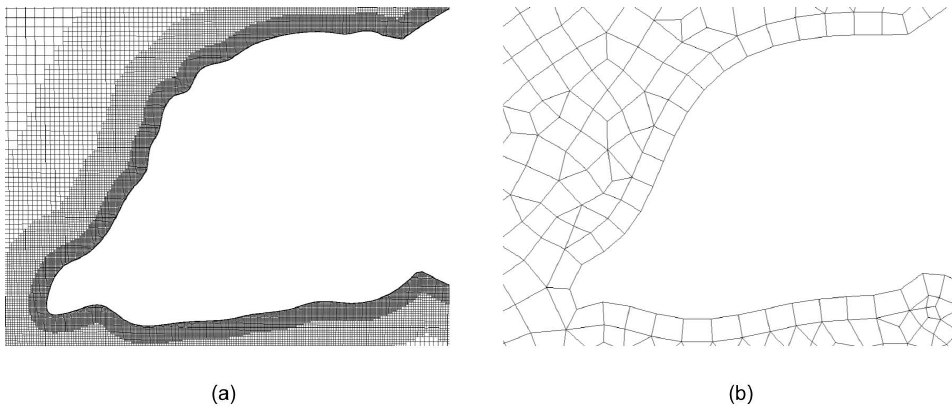
Figure 5. Comparison between: ( a ) fine (with fully resolved roughness) and ( b ) coarse (with RWFs) grids of profile 1. Table 1. Simulation cases and its grids.